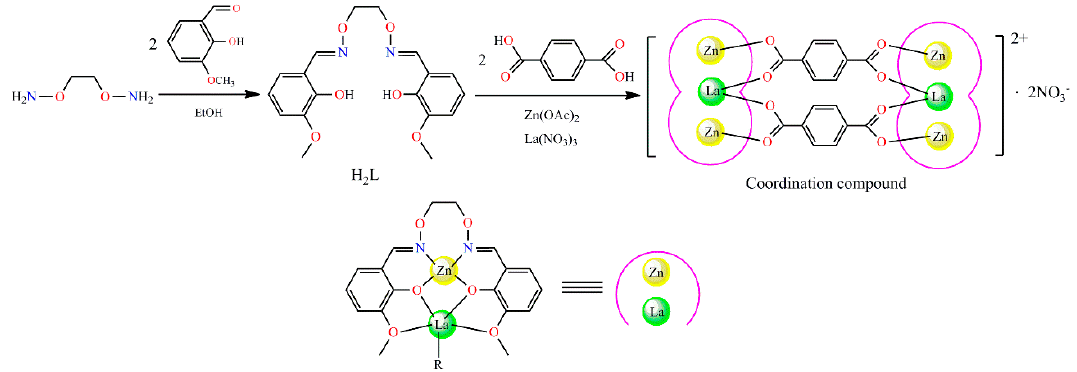
Table 1. Crystal data and structure parameters for the Zn(II)-La(III) coordination